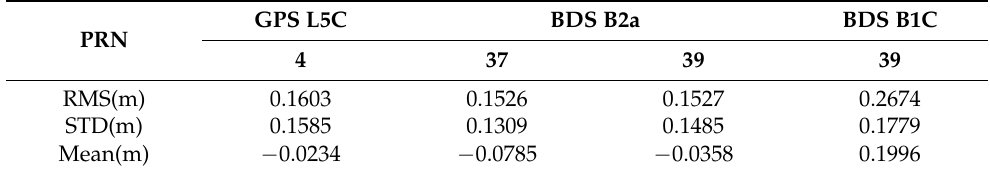
Table 2. Statistical characteristics of code delay.